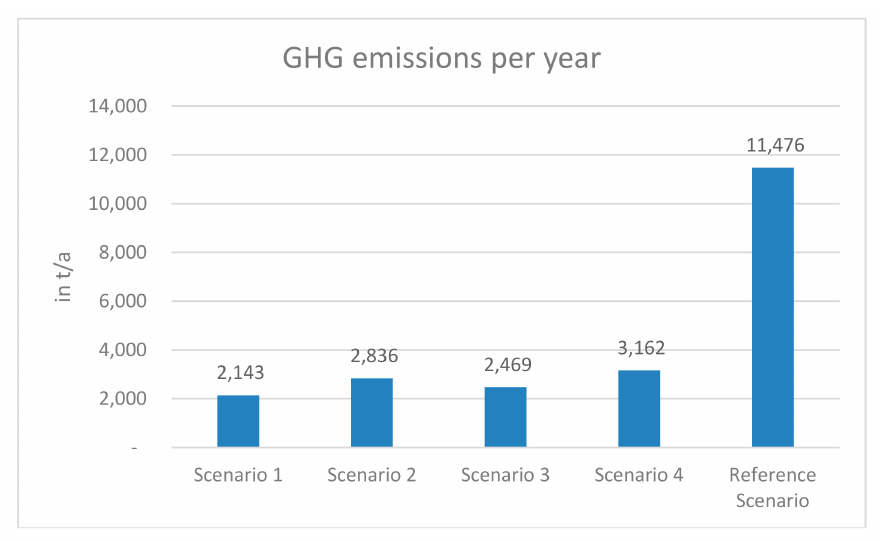
Figure 8. CO 2 emissions by